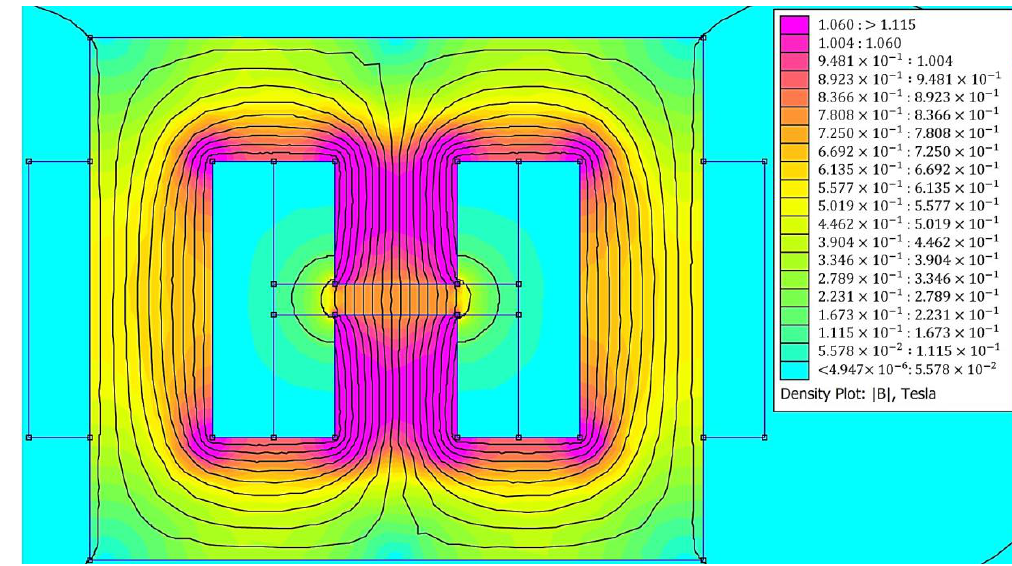
Figure 10. Magnetic analysis of the considered H-shaped electromagnet using FEMM software.